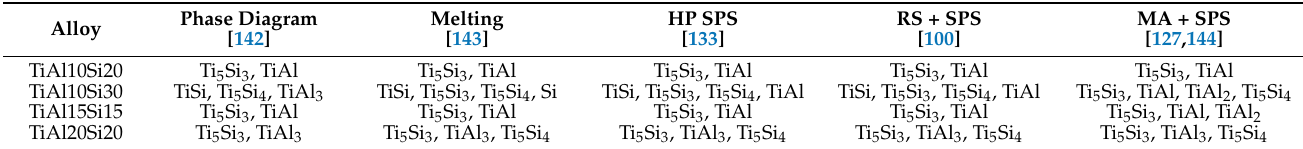
Table 1. Comparison of the phase composition of TiAl–Si